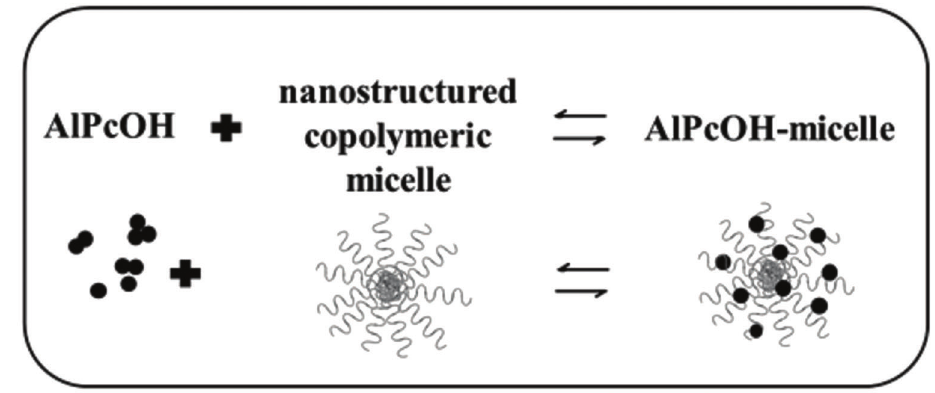
Figure 1. Schematic representation of the encapsulation of phthalocyanine AIPcOH into the Pluronic s F-127 micelle.